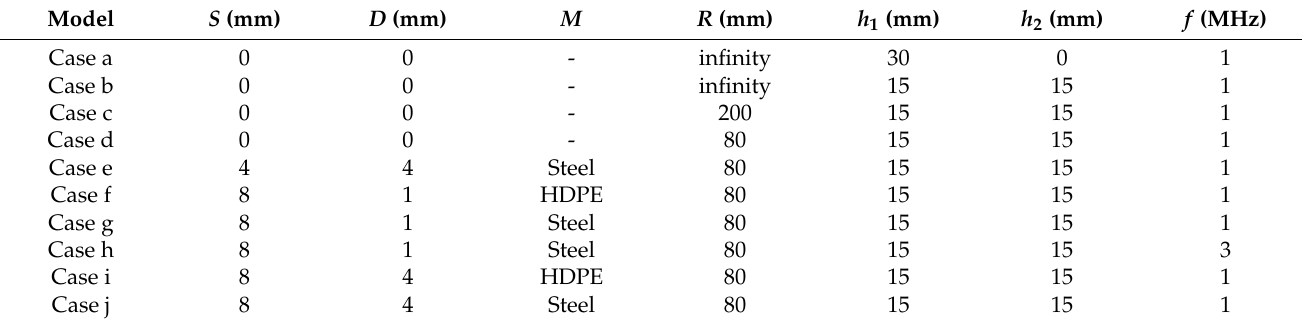
Table 2. Parameters used in the ten simulation